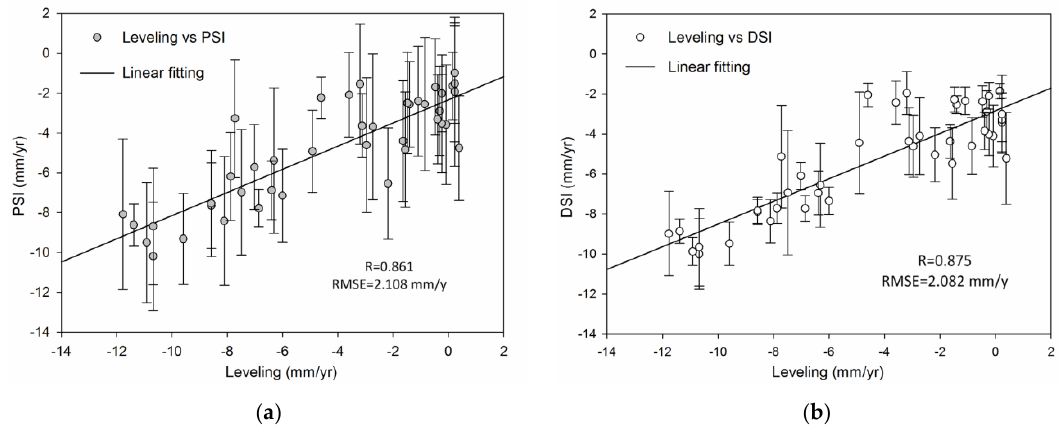
Figure 10. Scatterplot with error bars for the InSAR-retrieved deformation rates and levelling measurements: ( a ) PSI method and ( b ) DSI strategy.